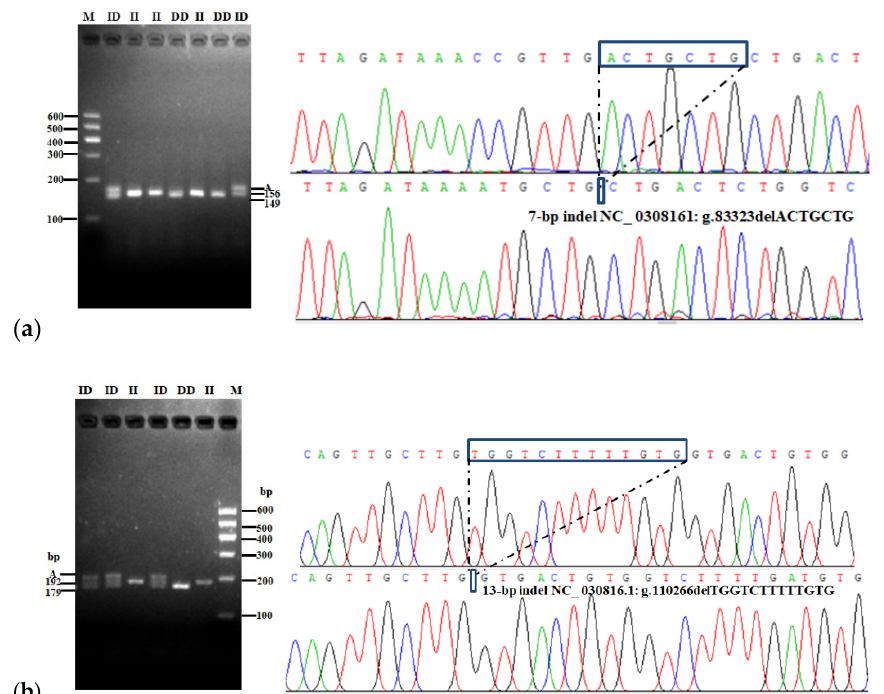
Figure 1. Agarose gel electrophoresis (3.0%) of PCR product of the goat AKAP12 gene for P1–7 bp ( a ) and P2–13 bp ( b ) indel variants in Shaanbei white cashmere goats. Note: II, homozygous insertion/insertion genotype; DD, homozygous deletion/deletion genotype; ID, heterozygous inser- tion/deletion genotype. The M represents the marker. A represents the non-target fragment called heteroduplex.